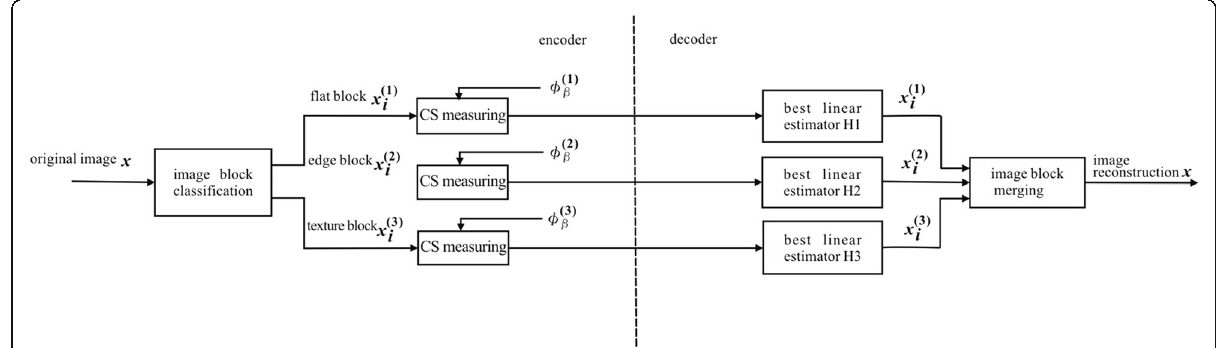
Fig. 1 Flow chart of non-photorealistic artistic processing in modern product